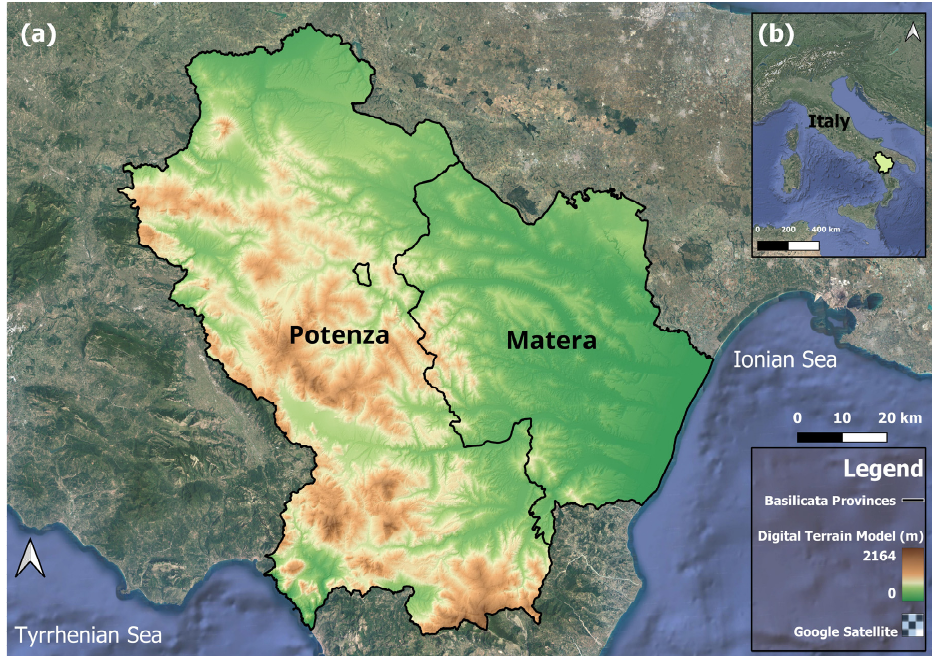
Figure 1. ( a ) Subdivision of Basilicata territory in the two provinces; ( b ) Geographical location of Basilicata Region within the Italian context. The Basilicata Region is one of the most hazard-prone areas of the Italian territory with a strong hydrogeological instability. Nearly 50% of the towns are exposed to a high risk of landslides or floods [74,75]. The area affected by flood risk is 260 km 2 wide (2.6% of the whole territory) and mainly includes the hilly areas and the coastal belt, which are exploited in agriculture, the main regional economic source [76]. The territory of the Basin Authority of Basilicata falls within the Hydrographic Dis- trict of the southern Apennines which provides flood hazard (http://www.adb.basili- cata.it/adb/pStralcio/pericol_alluv.asp, accessed on 8 January 2023) risk maps (http://www.adb.basilicata.it/adb/pStralcio/rischio_alluv.asp, accessed on 8 January 2023) as well as the Flood Risk Management Plan (https://www.distrettoappenninomeridio- nale.it/index.php/definizione-e-competenze-menu-pgra, accessed on 8 January 2023). Moreover, data about coastal flooding are provided for the Ionian and Tyrrhenian coastal zones (http://www.adb.basilicata.it/adb/pStralcio/maregg_alluv.asp, accessed on 16 Janu- ary 2023. The Flood Risk Plan is the regulative framework aiming to identify the riverbeds, floodplains, and next areas that can be flooded in case of flow discharges with return pe- riod until 30 years, 200 years, and 500 years [15]. It also provides management, mitigation strategies, and restraints to land use in flood risk areas, in order to reduce damages pro- duced by human activities and natural phenomena and to preserve natural hydraulic dy- namics of water surface bodies [77]. In this respect, the flood hazard maps identify the geographical areas that could be affected by floods according to the three main flood scenarios. For each scenario, the ex- tent of the flood, water height, velocity, and flow rate are indicated for the major water- courses and some of their tributaries [78]. These maps also contain indications of alluvial phenomena with a high volume of transported sediments and debris flows. The floodable areas at different return periods were mapped using digital topographic cartography